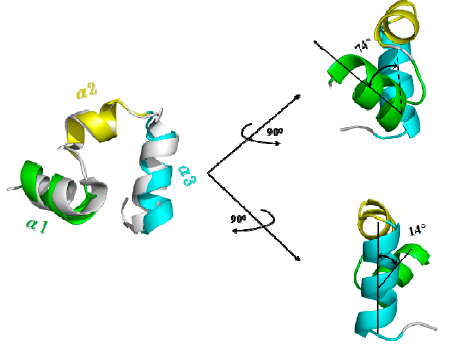
Figure 5. Simulated average structure for HP35-R model viewed from different directions with the superposition for the simulated structure and the crystal one in gray (PDB: 1YRF) on the left. The three helices of α 1, α 2 and α 3 for the simulated structure are colored in green, yellow and cyan, respectively. The interhelical angle value between α 1 and α 2 helices, and the dihedral angle value between the planes of α 1– α 2 and α 2– α 3 are given.